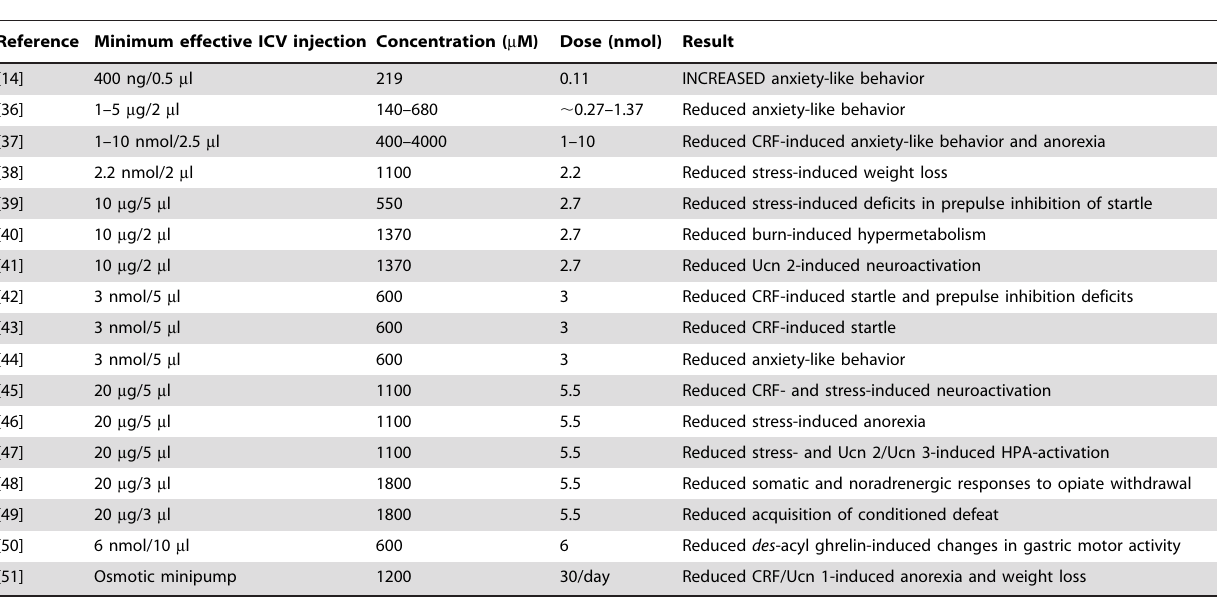
Table 1. Intracerebroventricular (ICV) studies of antisauvagine-30 effects on stress- or anxiety-related